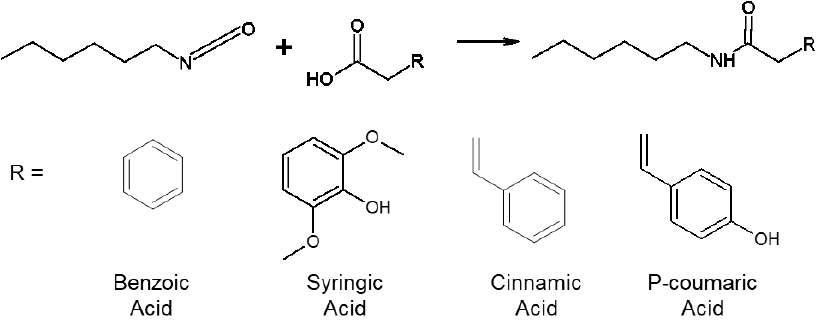
Figure 2. Synthesis of modified phenolic acids to serve as analogs for phenolic acids after incorporation into a polyurethane biomaterial.